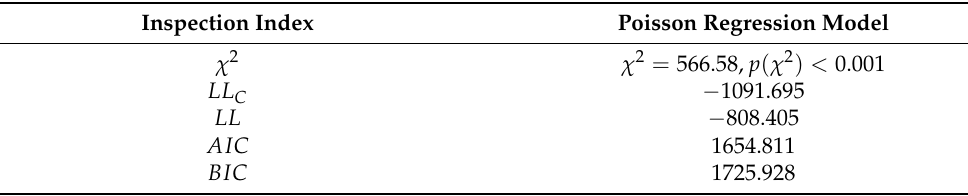
Table 7. Results of the Poisson regression model